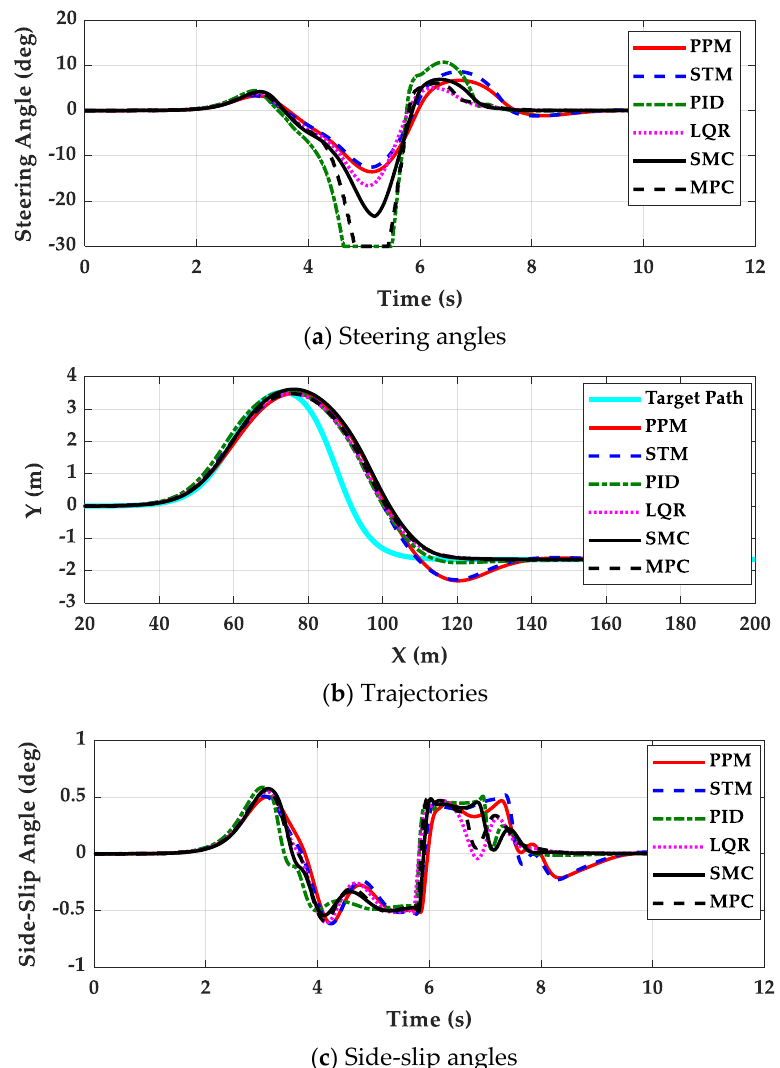
Figure 8. Simulation results of each controller for FWS vehicle on low- µ road obtained from the third set of